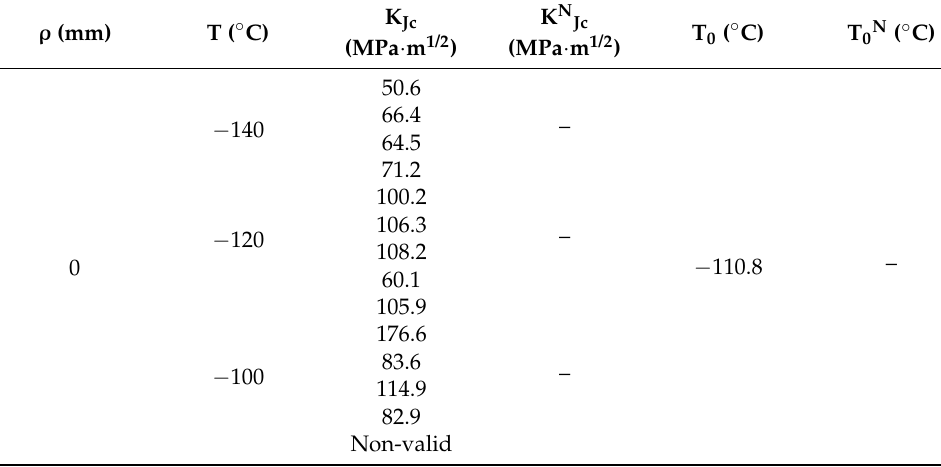
Table A4. Fracture toughness (K Jc ) and apparent fracture toughness (K N Jc ) results in steel S690Q, together with reference temperature results. 0.6T (15 mm thick) SENB specimens. Results converted to 1T equivalent